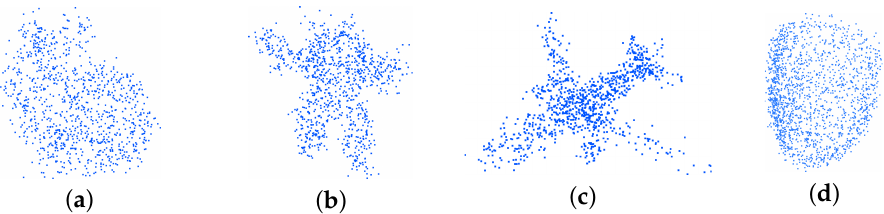
Figure 7. Point clouds with Gaussian noise, σ = 0.05: ( a ) Stanford Bunny; ( b ) Armadillo; ( c ) airplane; ( d ) human face.